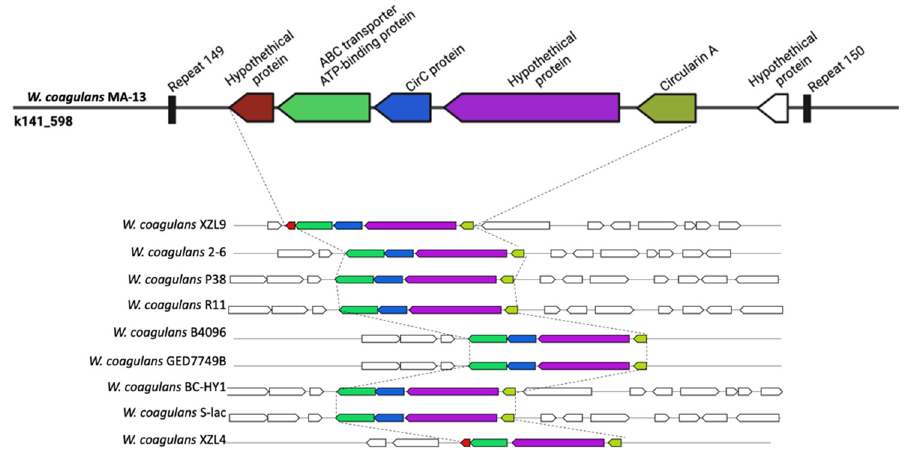
Figure 6. Graphical representation of circularin A gene cluster in diverse W. coagulans